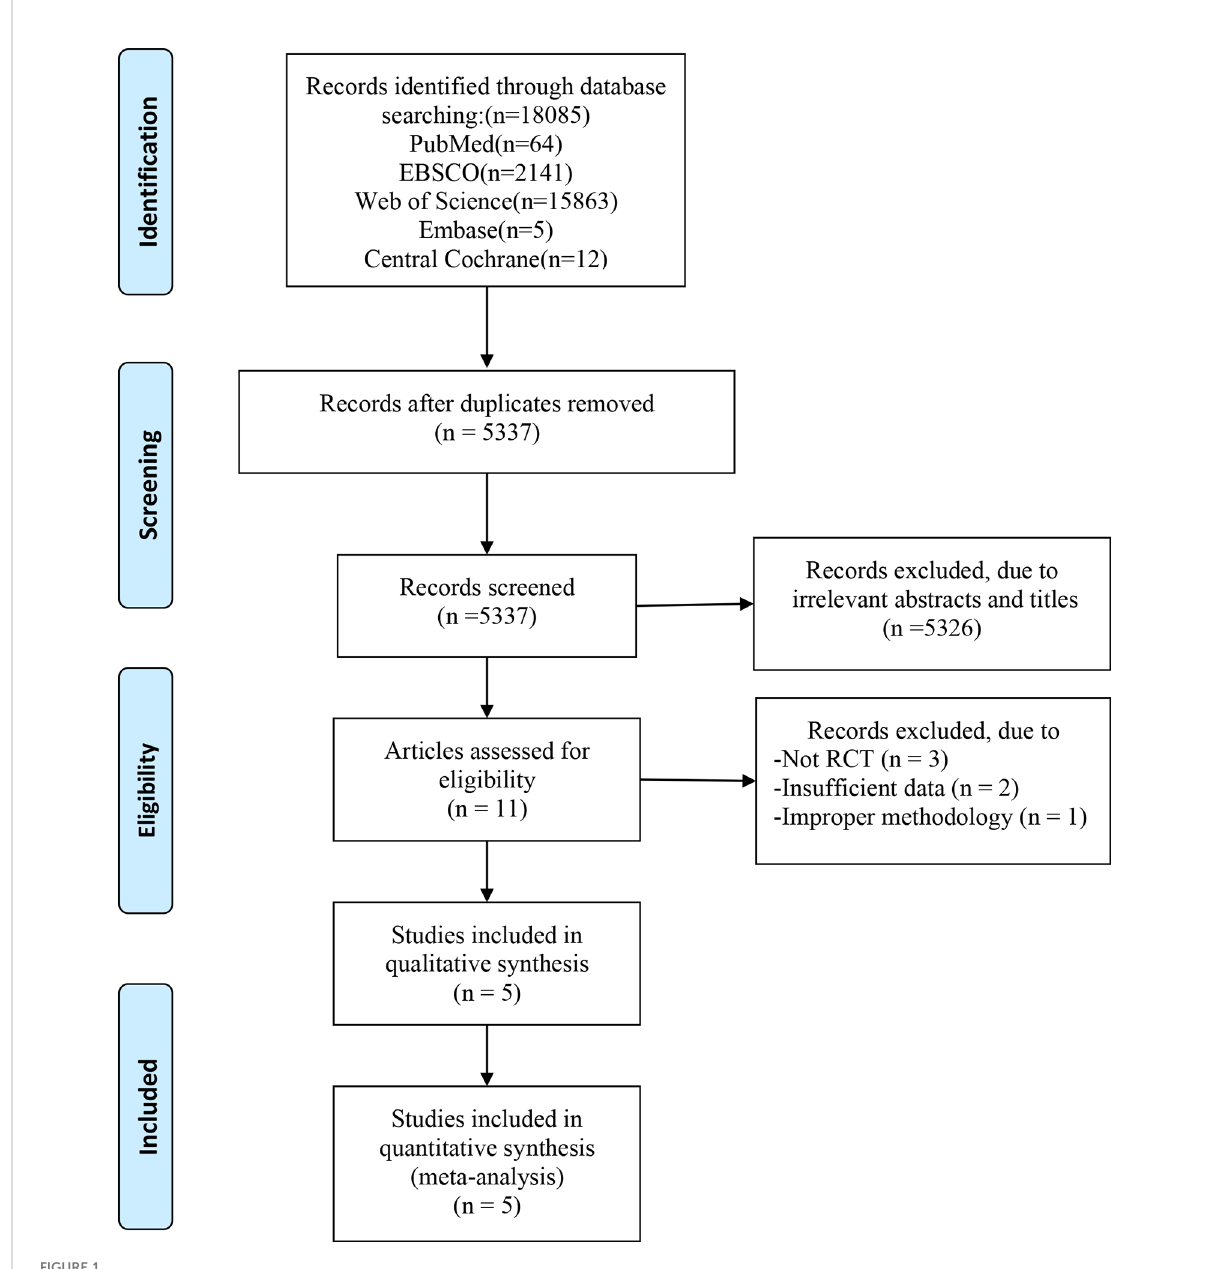
FIGURE 1 PRISMA fl ow